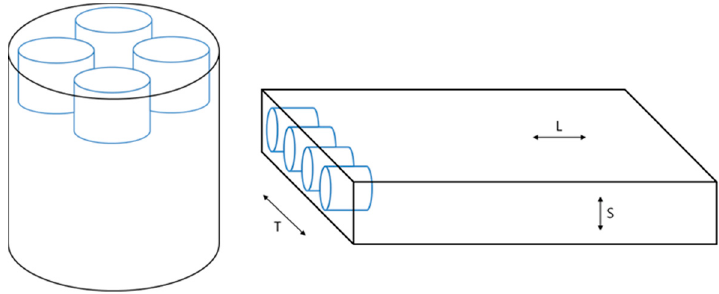
Figure 3. Orientation of OT specimens for ‘Rod’ and ‘Plate’ heats. Table 3. Dimensions of ovalized tube (OT) specimens.